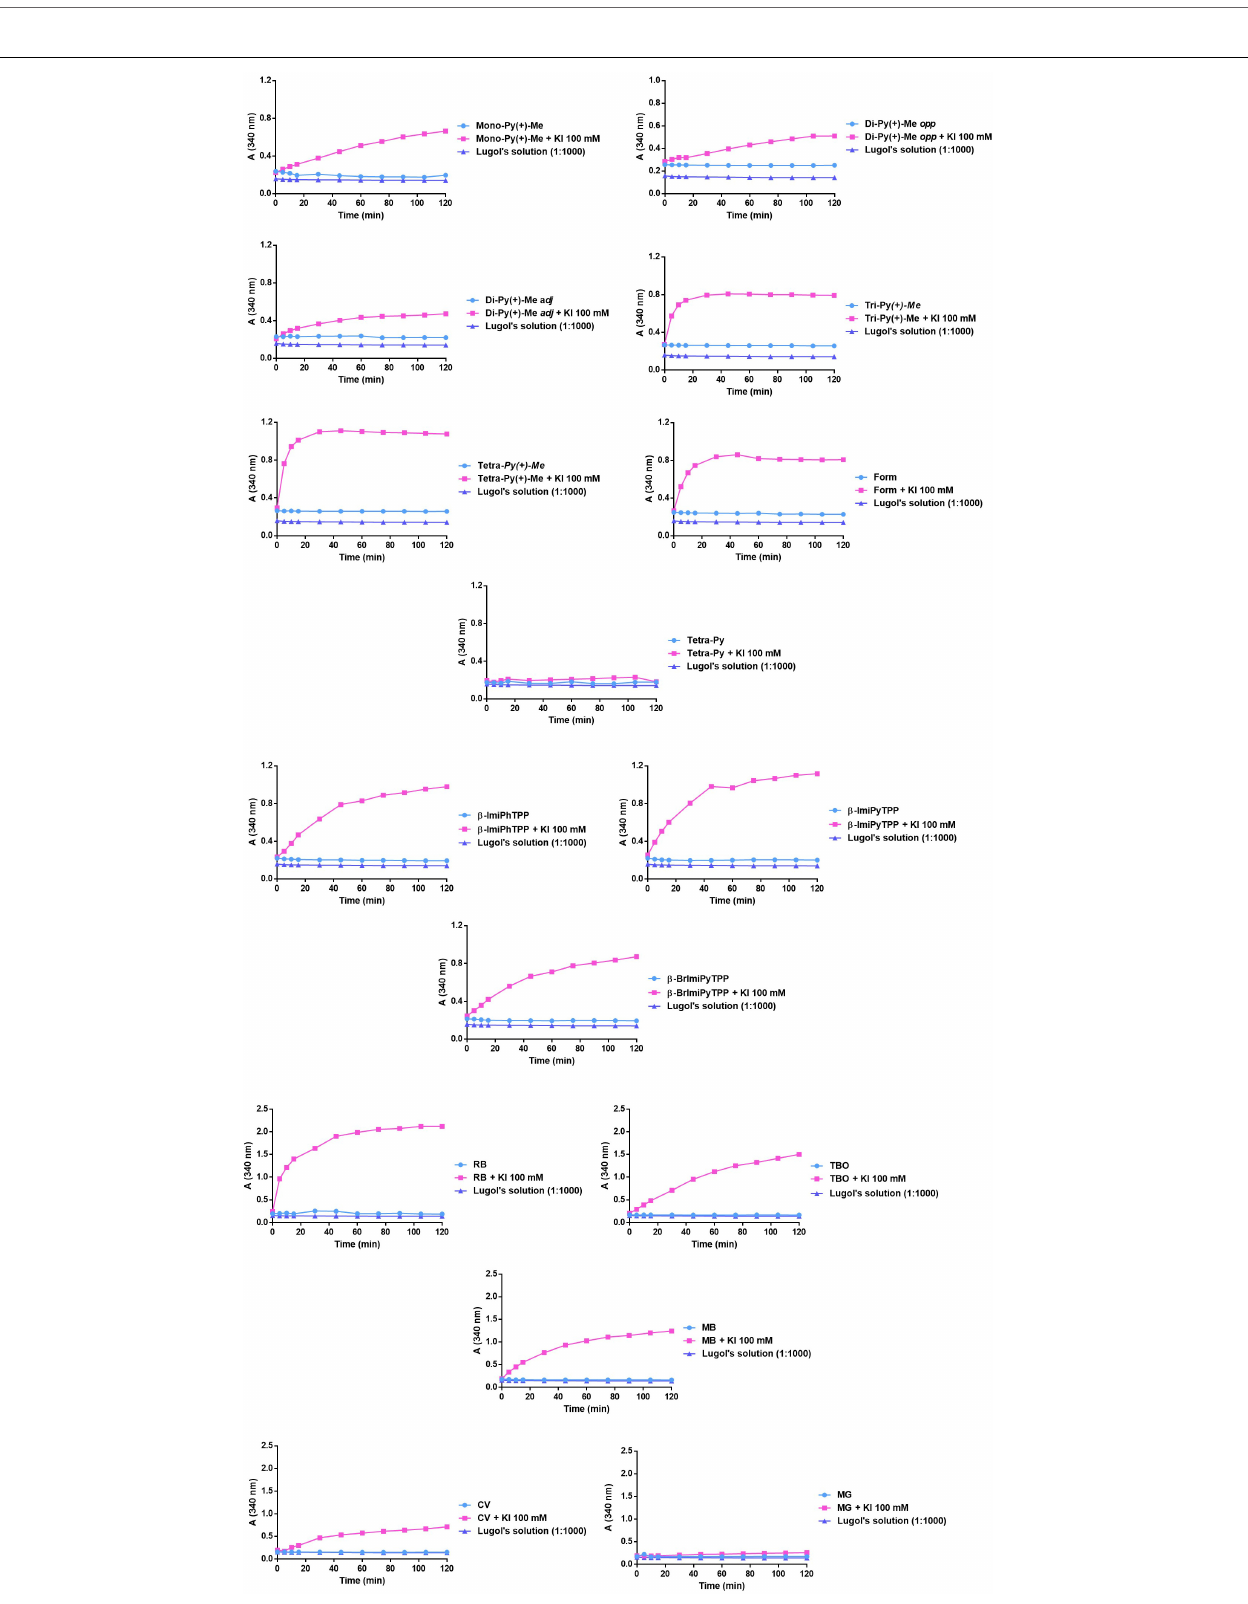
Frontiers in Microbiology |